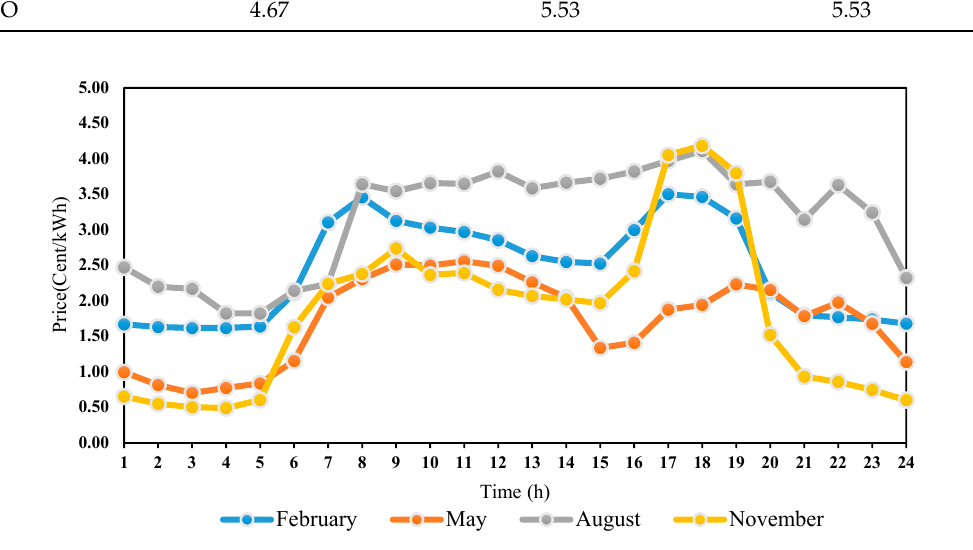
Figure 3. Price of selling energy to DSO.